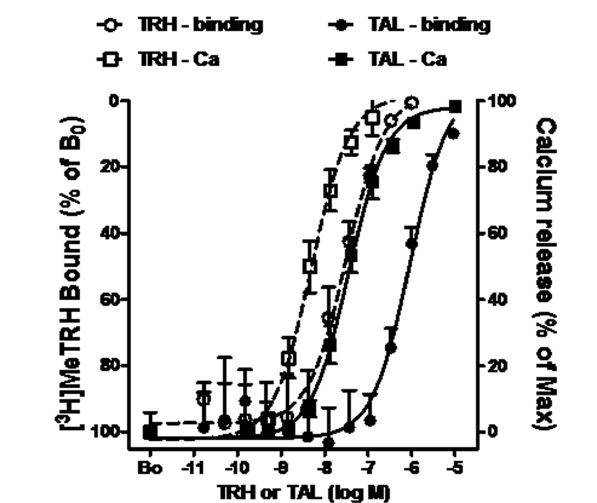
FIGURE 2 |TAL andTRH binding and signaling via Ca 2 + in cells expressingTRH-Rs. Competition binding with [ 3 H]MeTRH and changes in cytosolic free Ca 2 + concentration (Ca 2 + release) were performed in intact HEK-EM 293 cells stably expressingTRH-Rs as described in the legend to Figure 1.The competition binding data are presented as the % of [ 3 H]MeTRH bound to cells in the absence of unlabeled ligand (B 0 ) and represent the results from three experiments conducted with duplicate measurements. Note the left axis is inverted. Intracellular Ca 2 + release data are shown as a % of the maximal Ca 2 + increase over basal.The curves represent the non-linear regression analysis of data obtained in three experiments with duplicate or triplicate measurements using a sigmoidal dose–response method.